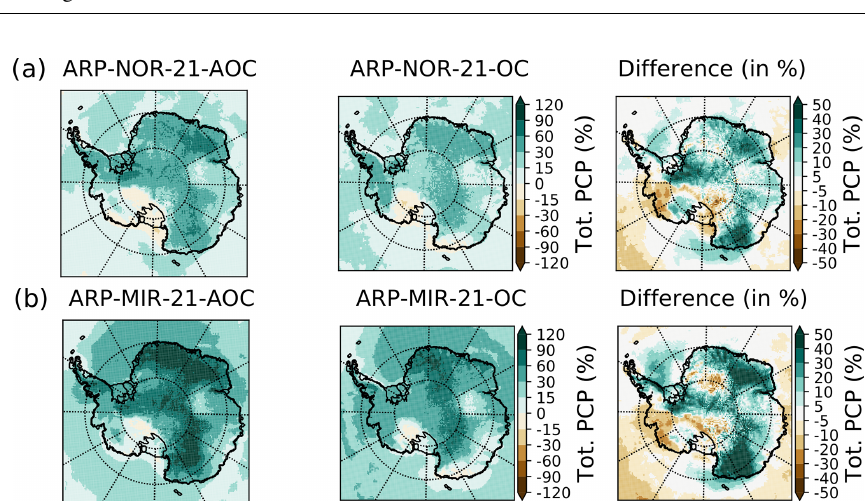
Figure 9. Late 21st century anomalies in yearly total precipitation (%) for ARPEGE RCP8.5 projections with atmospheric bias correction (left), uncorrected reference simulation (center) and difference (right). Results for projections with bias-corrected SSCs from NorESM1-M (respectively MIROC-ESM) are presented in panel (a) (respectively b